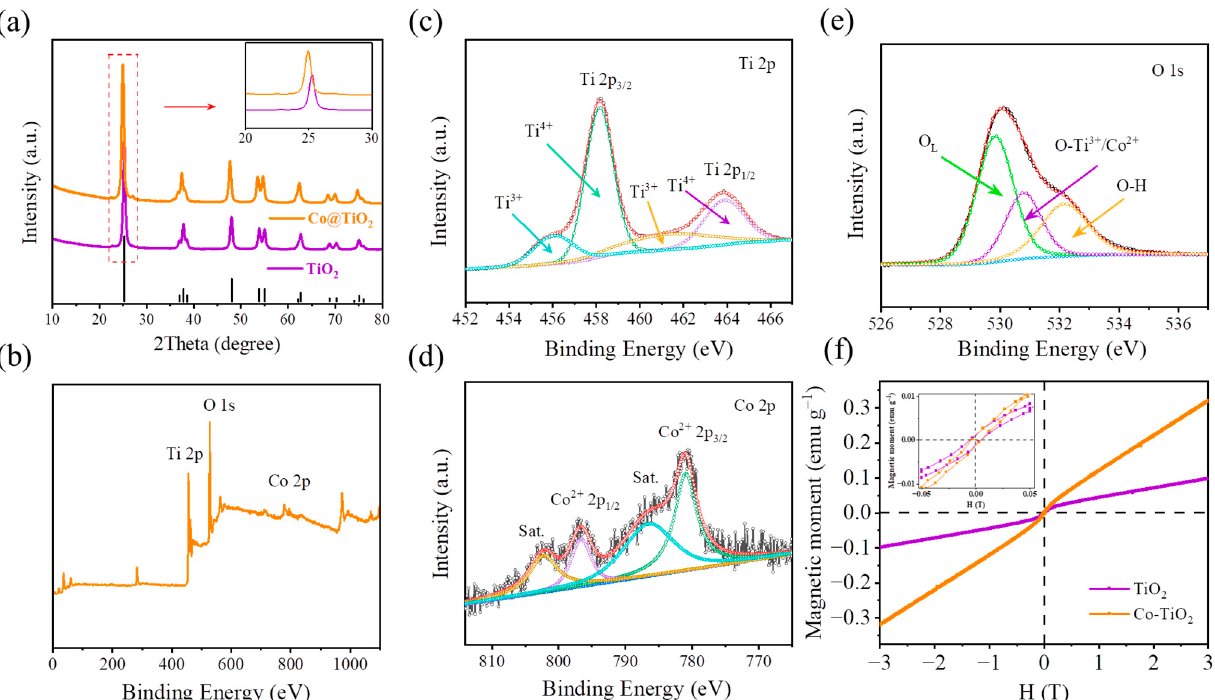
Figure 3. ( a ) XRD patterns of TiO 2 and Co@TiO 2 . The inset in Figure 3a is the corresponding enlarged XRD pattern from the typical peak. ( b ) XPS spectra of Co@TiO 2 . XPS spectra of the Co@TiO 2 sample: ( c ) Ti 2p, ( d ) Co 2p, and ( e ) O 1s. ( f ) Magnetic hysteresis loop for TiO 2 and Co@TiO 2 samples. The inset in Figure 3f shows the M ( H )